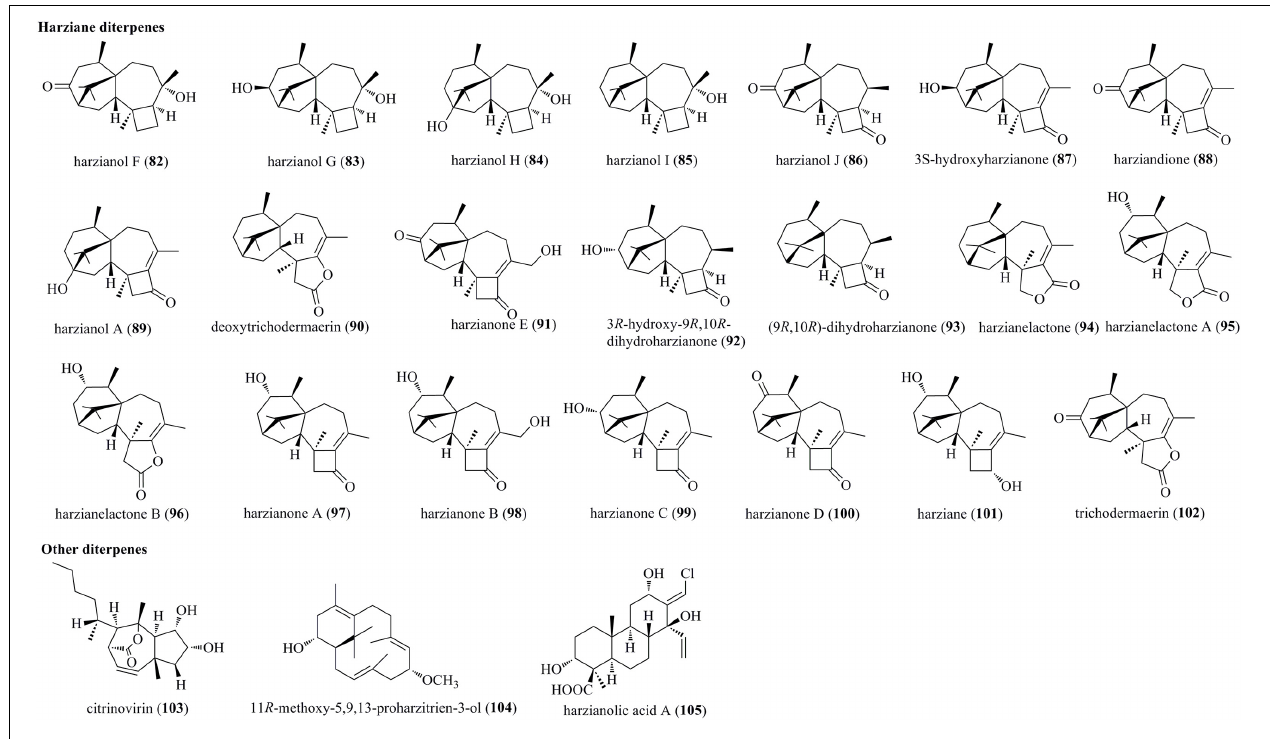
FIGURE 4 | Harziane and other diterpenes produced by Trichoderma species ( 82–105 ).